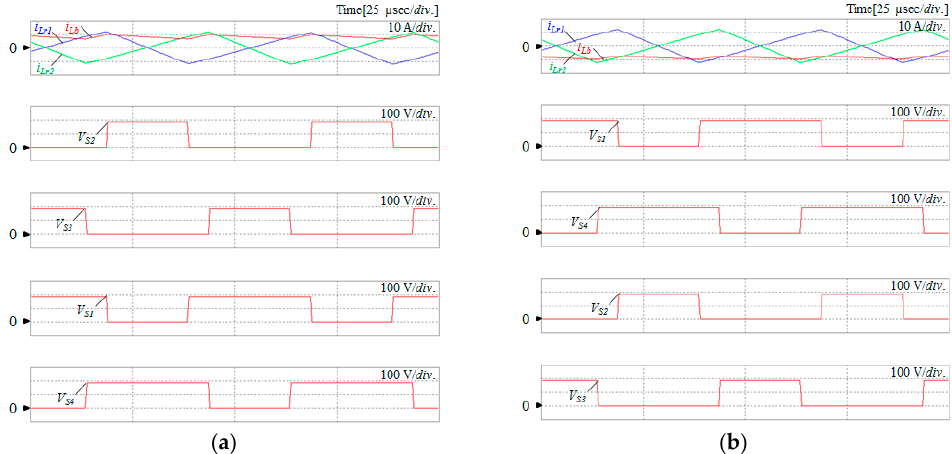
Figure 7. The simulation results of the proposed converter: ( a ) Step-up mode; ( b ) step-down mode.